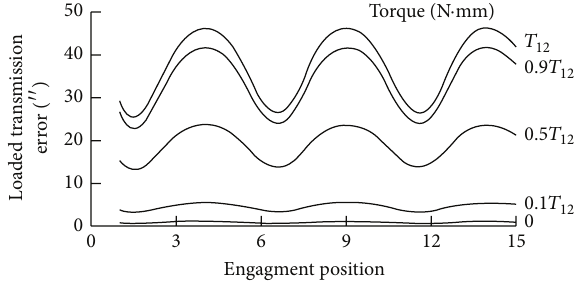
Figure 8: Loaded transmission errors under different